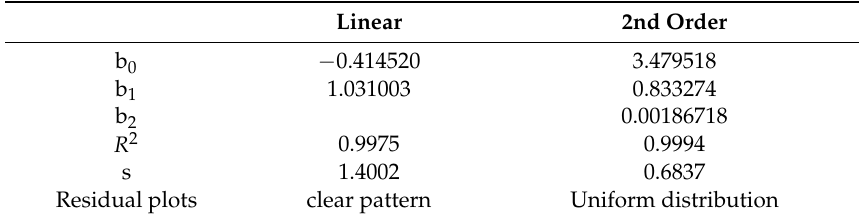
Table 7. Estimated parameters and evaluation criteria for the linear and polynomial equations for HMP 140A capacitive sensor using 11 salt